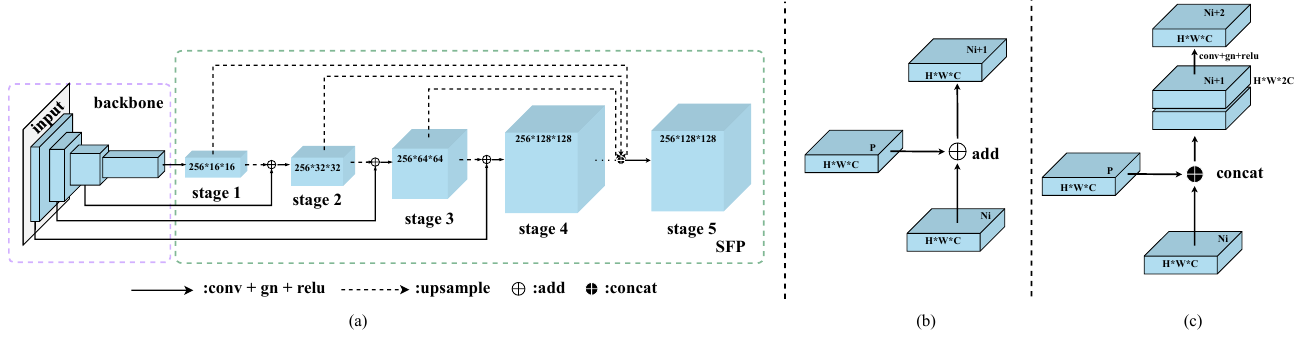
Figure 3. Hierarchical structure for spatial feature extraction. ( a ) The simplified feature pyramid (SFP) module pipeline. ( b ) The add method in SFP. ( c ) The concatenation method in SFP.